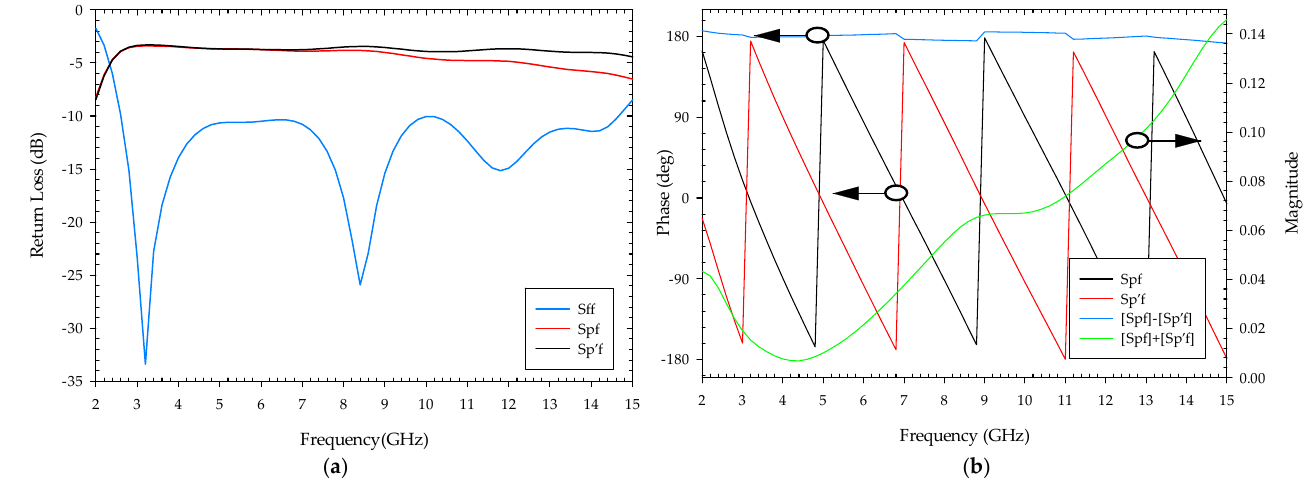
Figure 3. S-parameter with phase and magnitude at the end of the feeding network of the podal antenna: ( a ) feeding ends output return loss; ( b ) output port phases and a sum of magnitude.